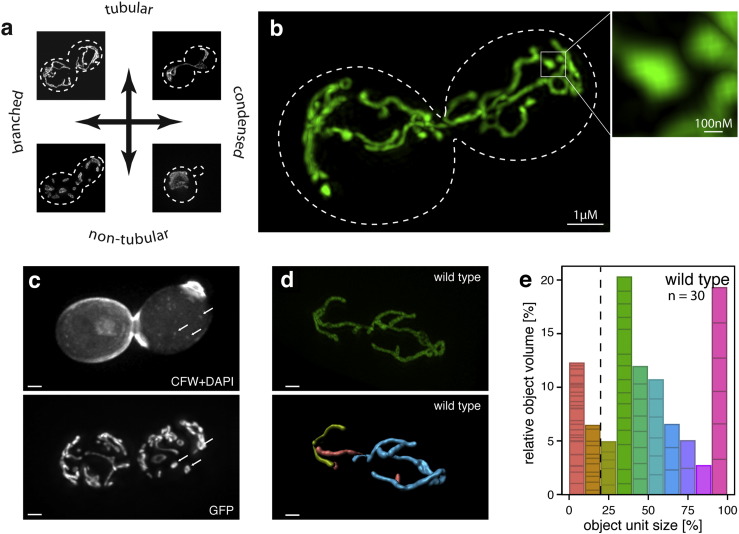
Super-resolution microscopy applied to measure network morphology of wild type yeast cells.(a) Schematic representation of mitochondrial network morphologies. While exponentially growing wild-type cells typically display a branched tubular network, oxidative damage or defects in fusion can lead to fragmentation, or condensed morphologies as a consequence of impaired mitochondrial fission.(b) 3D-SIM super-resolution microscopy applied to yeast mitochondria marked with pMitoLoc (green). Shown is the typical wild-type network morphology of an exponentially growing diploid YSBN1 cell, with resolution better than 100 nm.(c) Single fragmented mitochondrial units typically contain one mtDNA cluster. 3D-SIM super-resolution microscopy image of exponentially growing yeast cell treated with 1.0 mM H2O2, stained with DAPI (upper panel) and Calcofluor white (lower panel) to highlight DNA and the cell wall, respectively, and carrying pMitoLoc to mark the mitochondrial network. Scale bar = 1 μm.(d) Measurement of mitochondrial network morphology in wild-type cells using 3D-SIM. (Upper panel) preSU9-GFP (green) image of a typical mitochondrial network. Scale bar = 1 μm. (lower panel) 3D reconstruction of the network, with individual fragments colour-coded according to their relative size. Scale bar = 1 μm.(e) Stacked bar plot of mitochondrial fragment volumes binned by the relative contribution to the total mitochondrial volume, combined for 30 cells per genotype (population footprint). Colour coding as in (d). Objects smaller than 20% of the total volume are considered fragmented (dotted line).